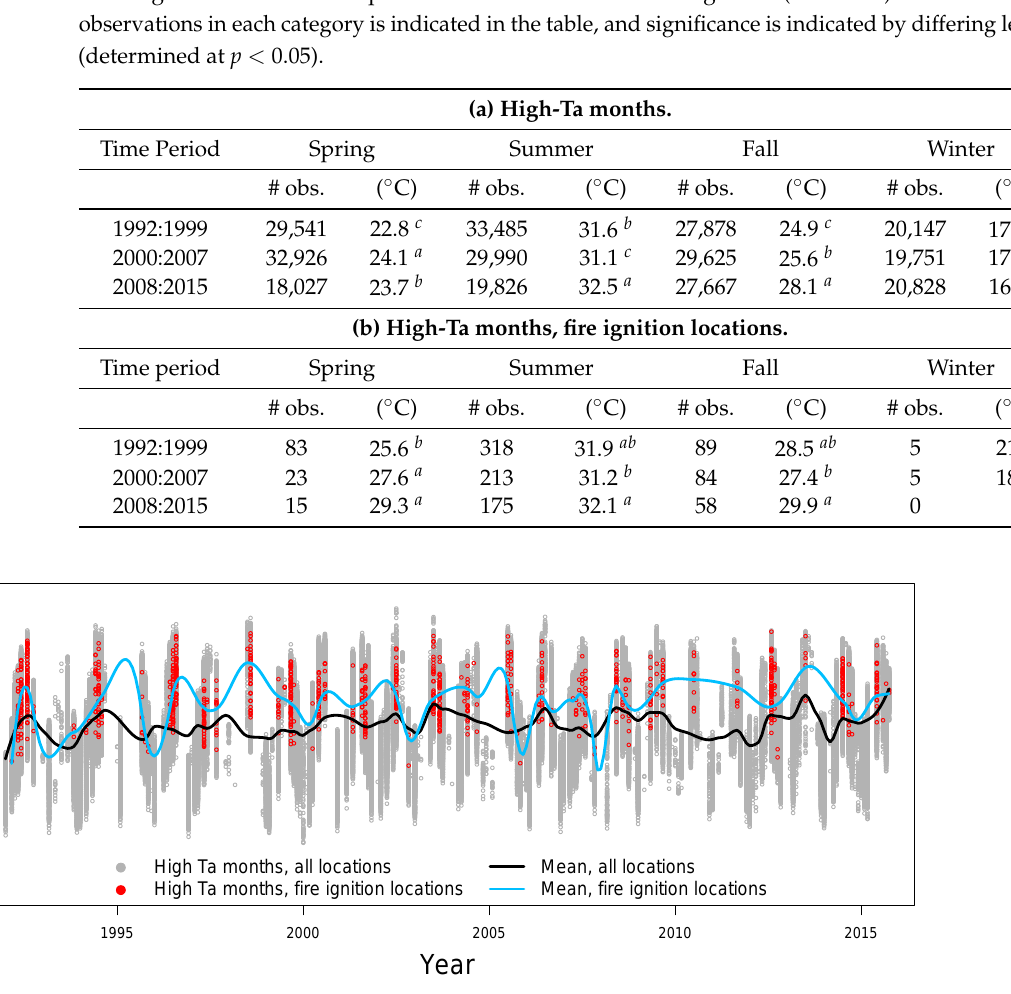
Figure 2. Timeseries of the magnitude of high-air-temperature months (Ta: ◦ C) across the Sierra Nevada region from 1992 to 2015, and the magnitude of high-Ta months for fire ignition locations in the month when ignition occurred. Lines were loess smoothed for